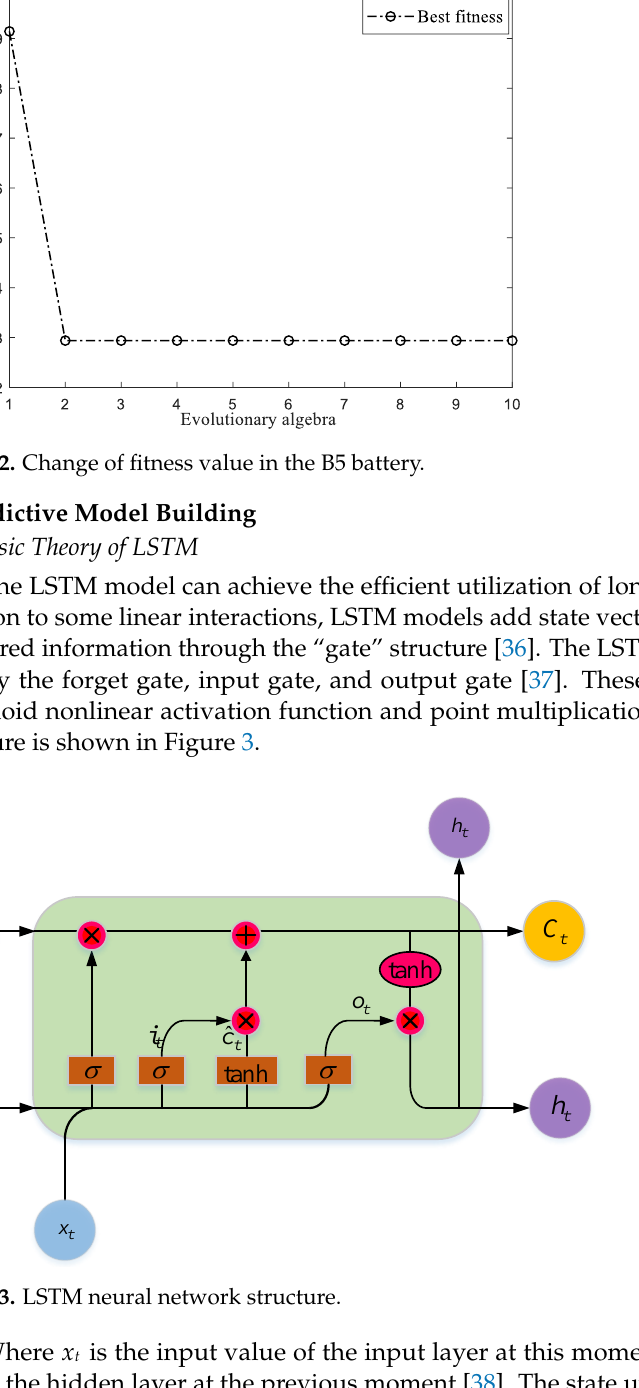
Figure 2. Change of fitness value in the B5 battery.